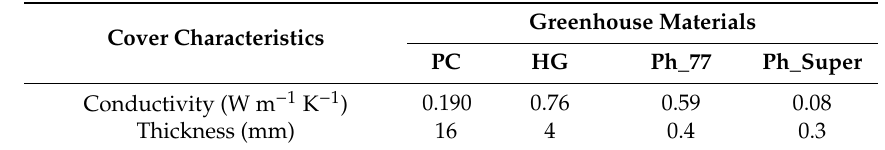
Table 2. Physical and thermal properties of the greenhouse coverings and thermal screens. Table 2. Cont.